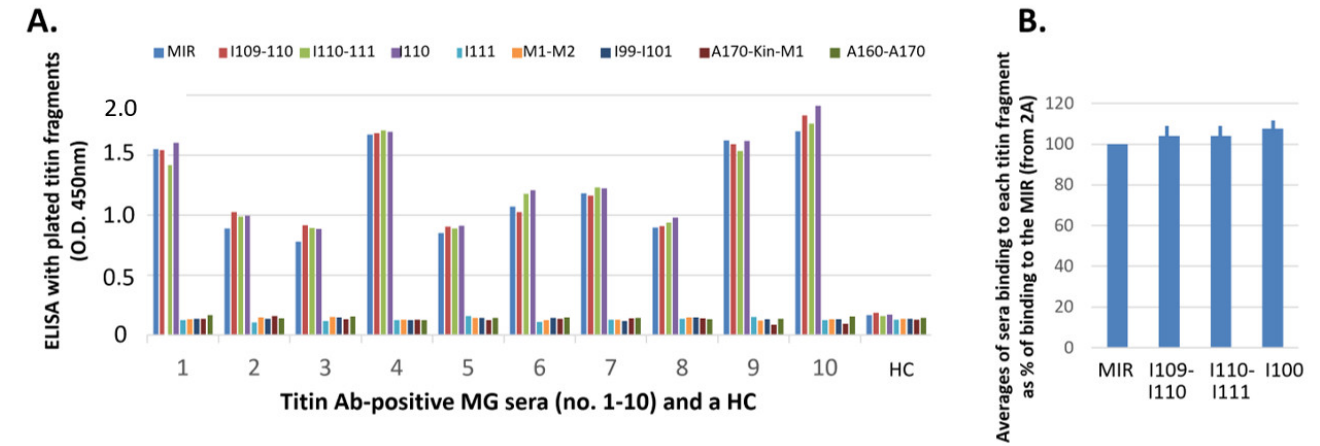
Figure 2. Binding of MG sera to the titin fragments by ELISA. Sera (from 10 MG patients and a healthy control, HC) were incubated with immobilized fragments: whole MIR, its domains I109-I110, I110-I111, I110 and I111, and the titin fragments outside the MIR region: M1-M2, I99-I101, titin kinase region A170-Kin-M1, and A160-A170. ( A ) It is shown that all sera were bound to all 3 fragments which contain the I110 domain, practically equally well with their binding to the whole MIR, but not to any other fragment. ( B ) Average percentages of antibody binding of the 10 sera to I109-I110, I110-I111, and I110, versus the values of antibody binding to the MIR. The differences are not statistically significant.